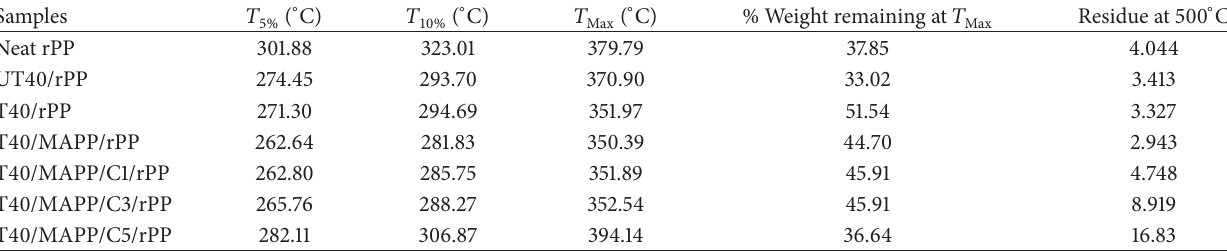
Table 5: Thermal properties of SF/rPP